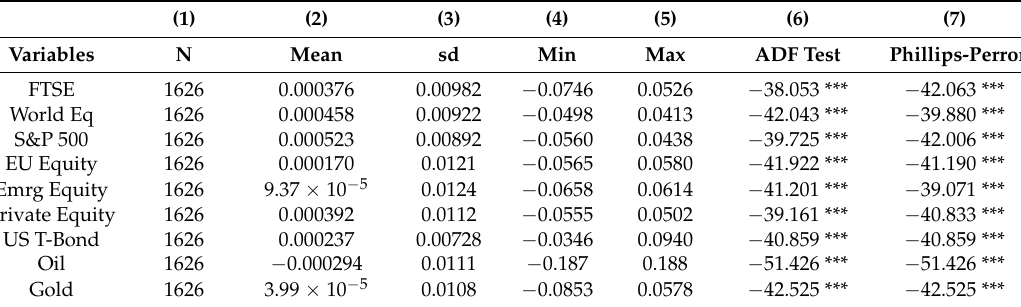
Table 2. Descriptive Statistics and Unit Root